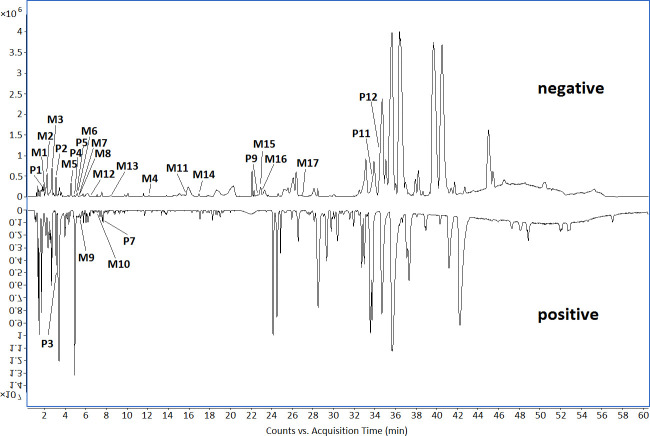
The base peak chromatogram (BPC) of chemical components absorbed in rat plasma in both negative and positive modes.